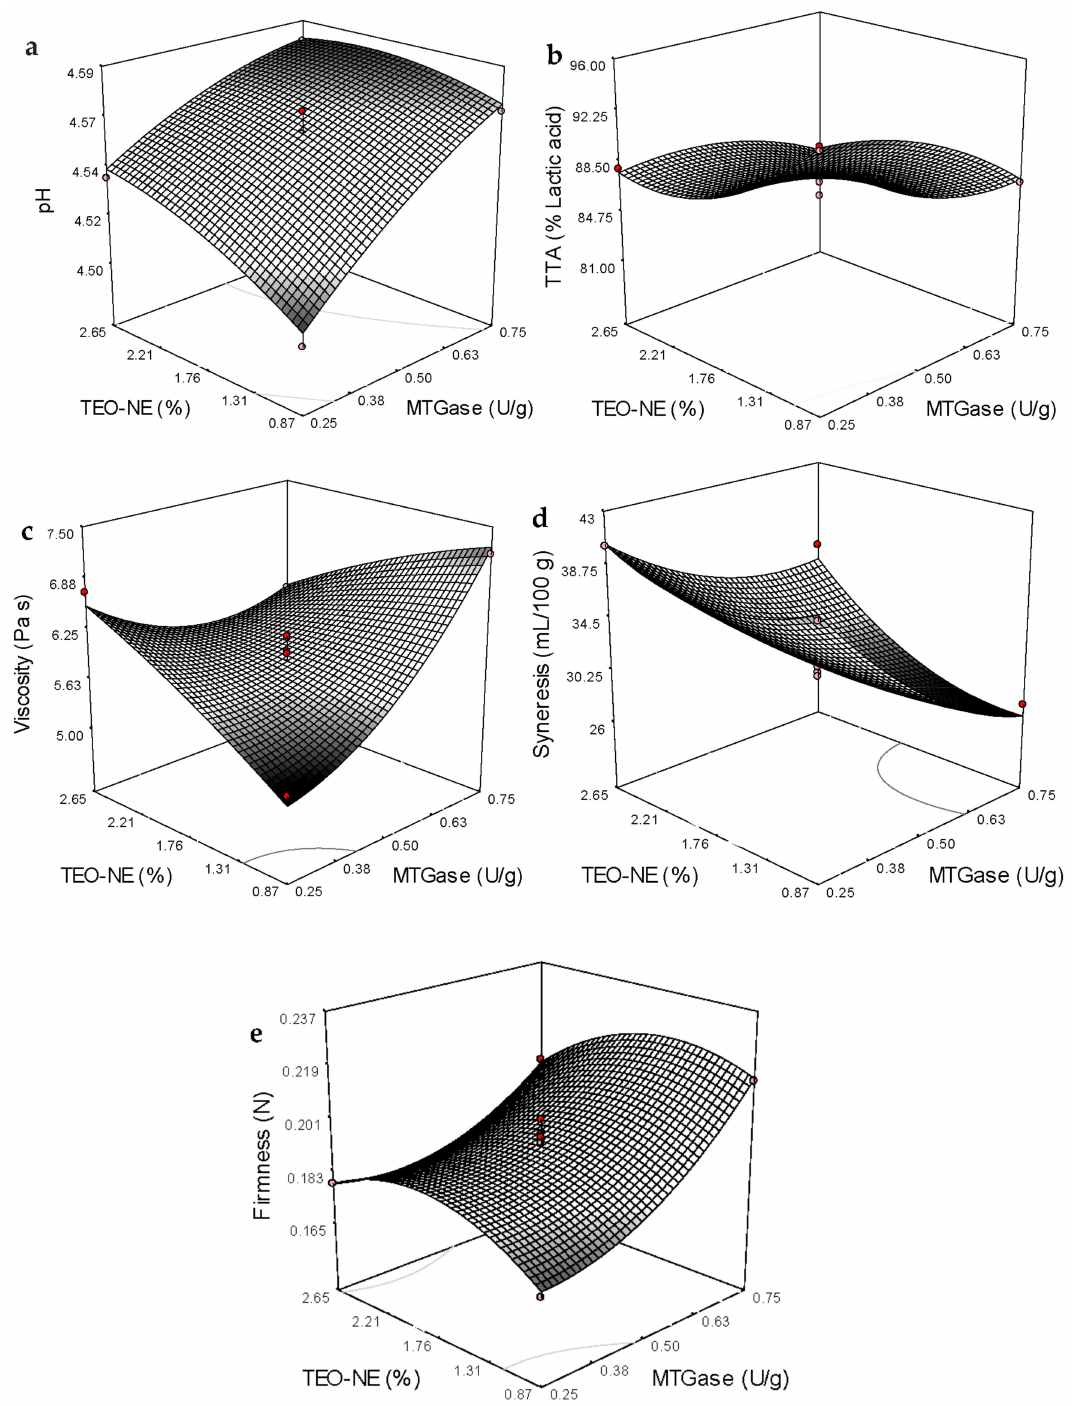
Figure 3. Three-dimensional surface plots showing the significant interaction effects on the variation of the pH ( a ), TTA ( b ), firmness ( c ), viscosity ( d ), and syneresis ( e ). The increased pH or reduced acidity in the presence of MTGase can hinder the growth of starter bacteria by limiting their accessibility to nitrogen sources such as amino acids through forming protein crosslinks. This complex protein matrix is able to retard lactic fermentation with a longer lag phase of starter bacteria, leading to a slower acidification with a lower production rate of organic acids, particularly LA [3]. Earlier, a rise in the pH value or a reduction in the acidification rate was reported in free-fat [39] and